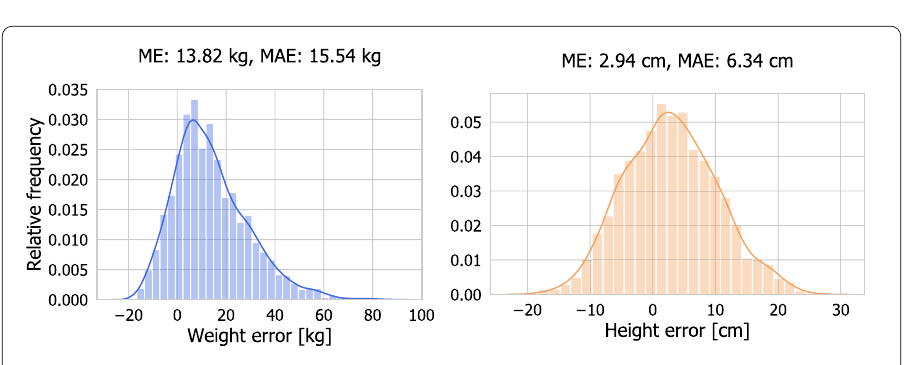
Figure 7 Distributions of weight and height errors